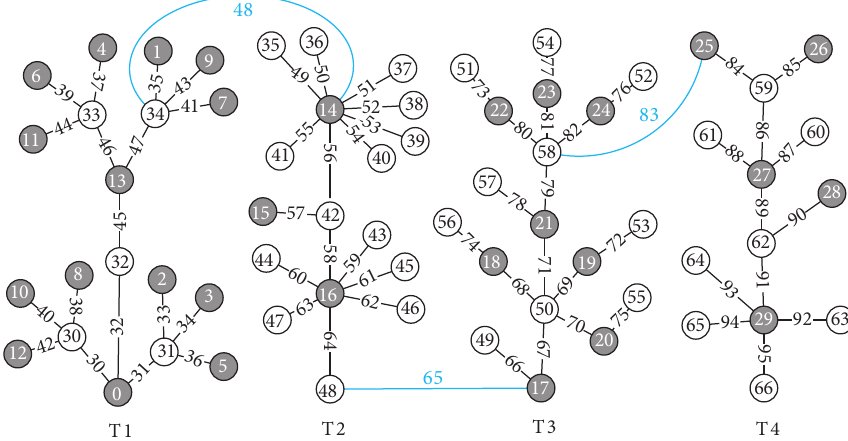
Figure 3: A caterpillar P